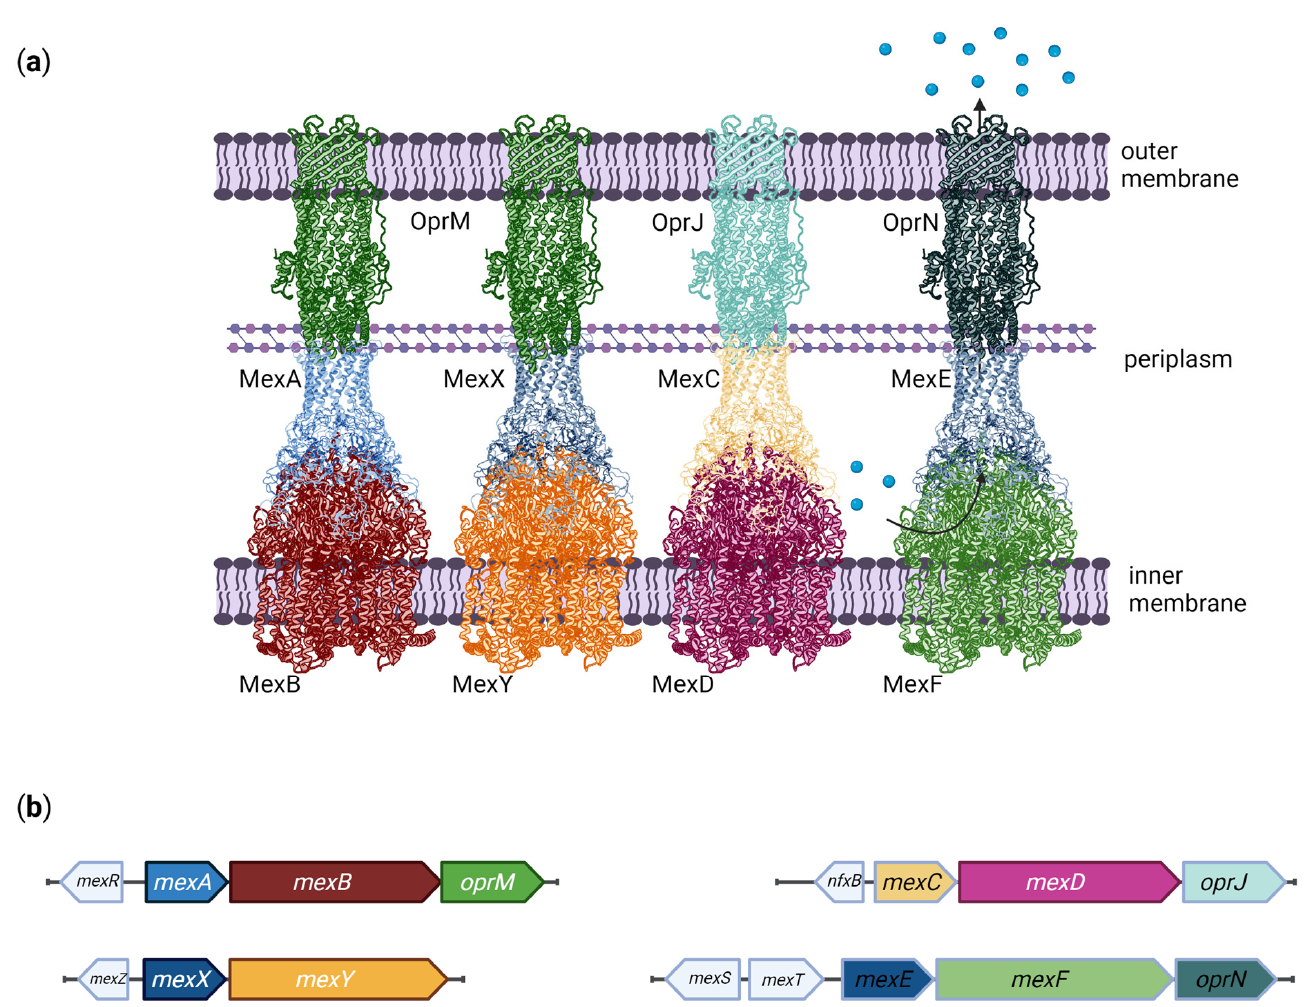
Figure 1. Multidrug efflux pumps in P. aeruginosa . ( a ) Schematic structures of the four main efflux pumps involved in antibiotic resistance in P. aeruginosa , showing the resistance-nodulation-cell division transporters (MexB, MexY, MexD and MexF) on the inner membrane; the periplasmic membrane fusion proteins (MexA, MexX, MexC and MexE) on the periplasm; and the channel-forming outer membrane factors (OprM, OprJ and OprN) on the outer membrane. Protein representations based on the Protein Databank (PDB) structures: 2V50, 4DK1 and 3D5K. ( b ) Organization of the Mex operons and upstream regulatory genes in the P. aeruginosa genome. Regulatory genes are represented in white, and the Mex coding sequences follow the same color patterns of the protein structures shown in ( a ). Created with